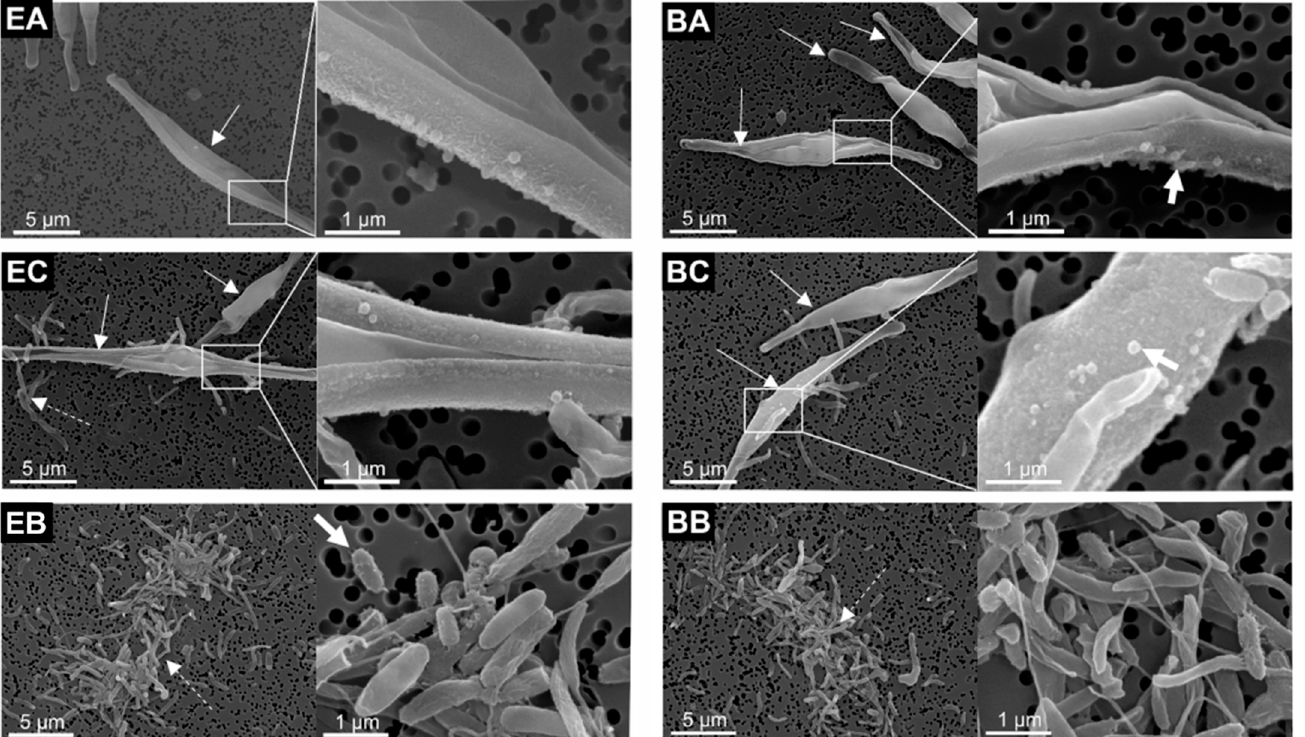
Figure 2. Scanning electron microscopy images of experimental (left side) and blank (right side) cultures of axenic microalgae (EA, BA, respectively), co-culture (EC, BC, respectively) and bacteria (EB, BB, respectively). Arrows point to fusiform cells (white arrows), bacteria (dashed white arrows) and protrusions on cell surface (fat white arrows). The insets in white rectangles are presented at higher magnification at the right side of the